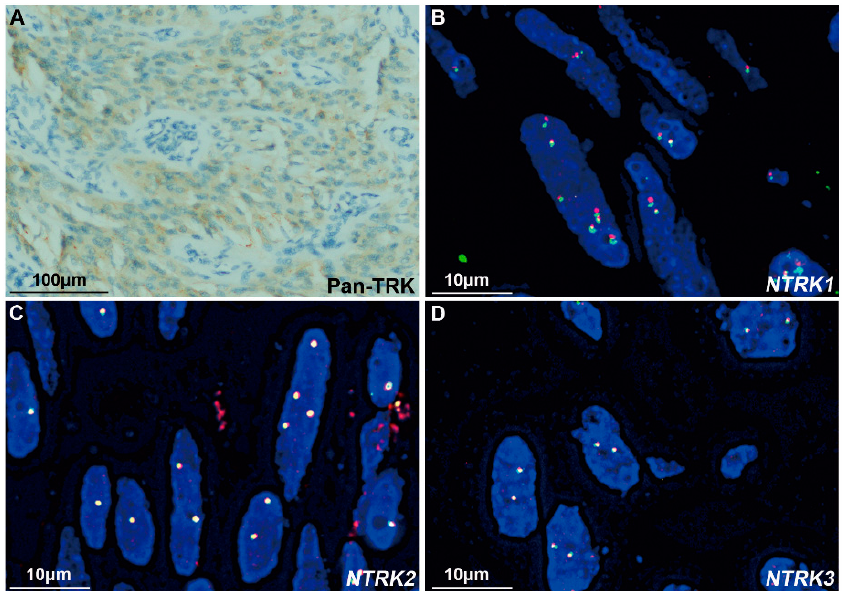
Figure 6. The tumor (case #6) with moderate expression of Pan-TRK and polyploidy involving NTRK1 . ( A ) IHC staining showed moderate cytoplasmic expression of Pan-TRK (400 × ). Scale bar is 100 µ m. ( B – D ) FISH images obtained using NTRK1 , NTRK2, and NTRK3 break-apart probes. Polyploidy, but not rearrangement, was observed in some tumor cells using the NTRK1 break-apart probe. The tumor was negative for NTRK2 and NTRK3 rearrangements. Each scale bar is 10µm.